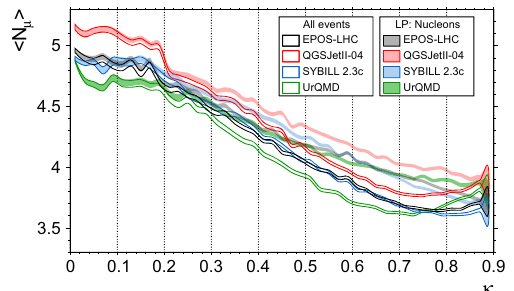
Fig. 5 Average number of ground level muons per event as a function of the first interaction inelasticity for nucleon led and all types of events